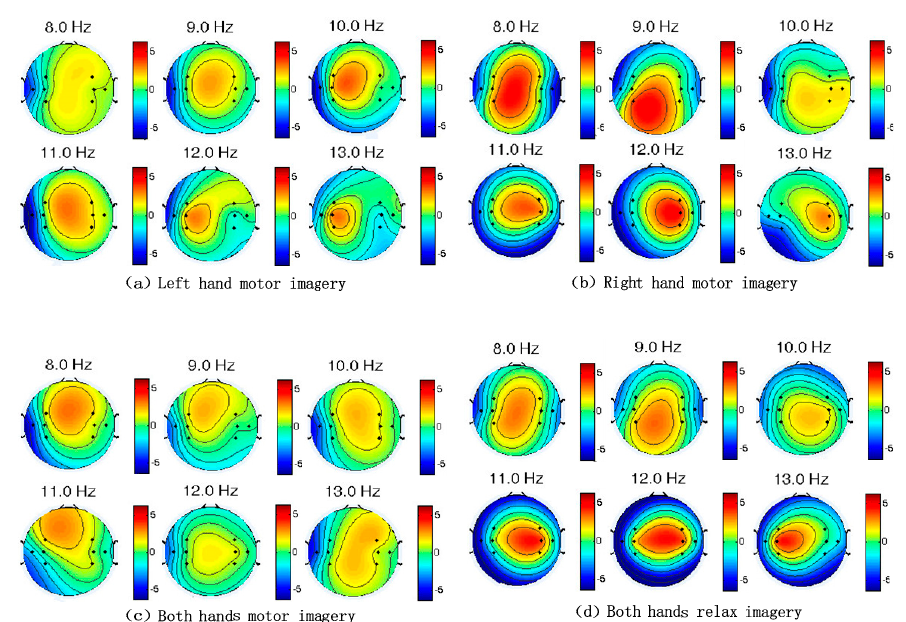
Figure 12. Topographies of power in 8–13 Hz frequency band during motor imagery of subject 2.